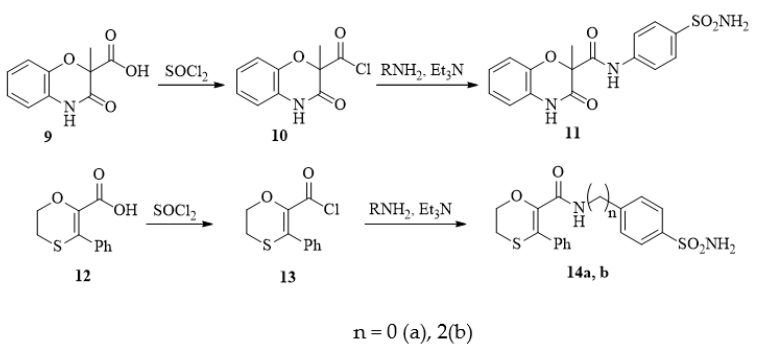
Scheme 1. Synthesis of furo[3,2- b ]pyrrole and thieno[3,2- b ]pyrrole derivatives. Synthesis of amides 11 and 14a,b is shown in Scheme 2. 2-Methyl-3-oxo-3,4-dihydro- 2 H -1,4-benzoxazine-2-carboxylic acid 9 [42] and